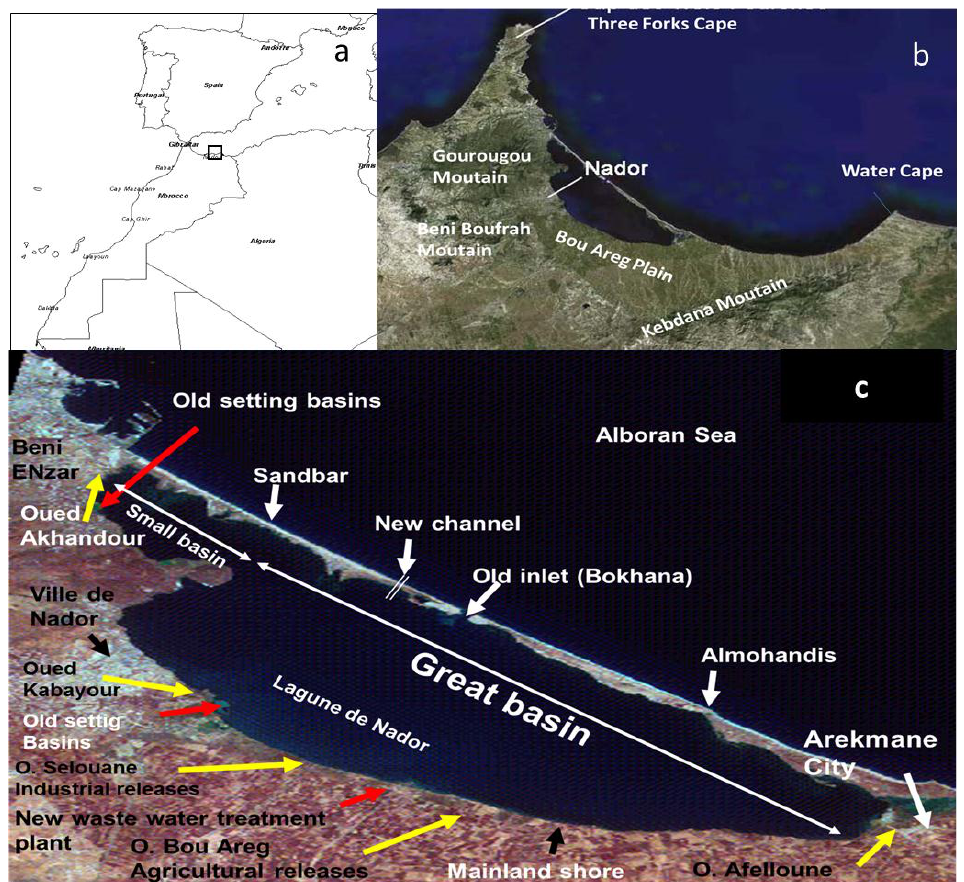
Figure 1. Maps showing Nador lagoon location ( a ) Lagoon watershed ( b ) and lagoon and freshwater hydrographic network (shown by yellow arrows), old settling basins and new wastewater treatment plant (shown by red arrows) ( c ) [7].